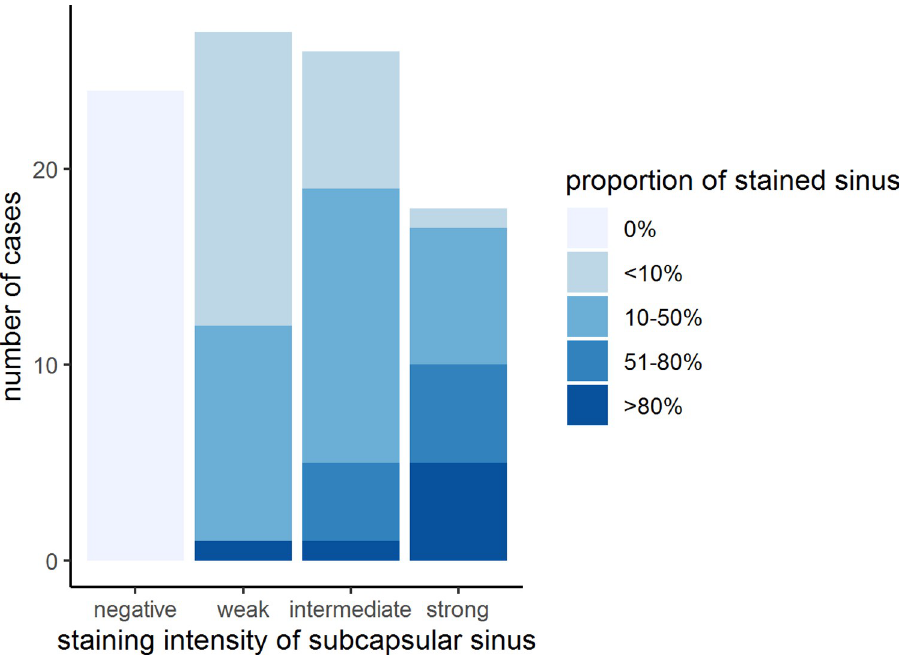
Fig 5. Correlation of staining intensity and proportion of stained sinus in SLN. A stacked bar plot visualizes the correlation of staining intensity and proportion of stained subcapsular sinus for D2-40, here within SLN.